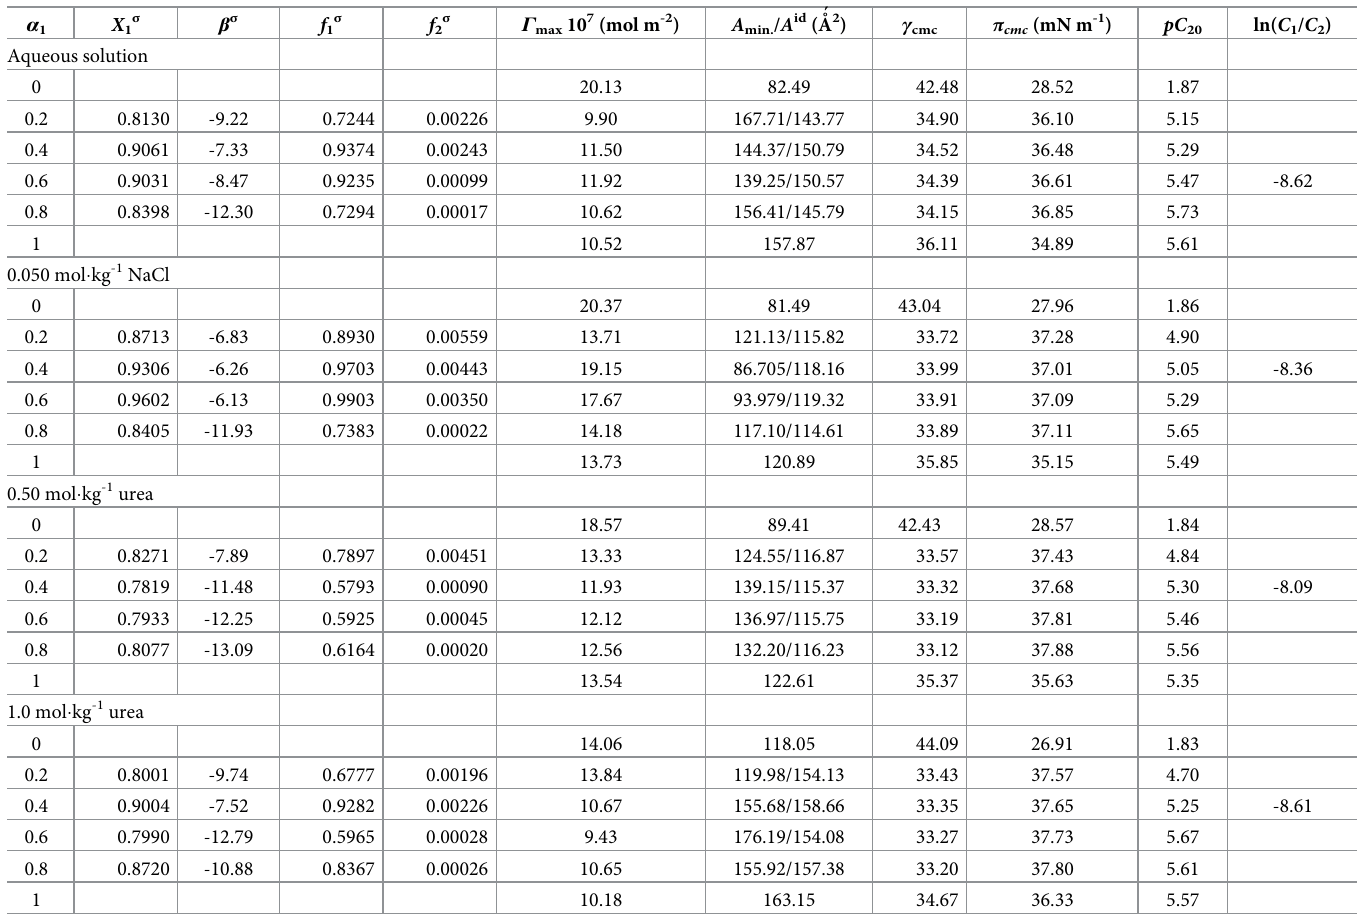
Table 2. Various interfacial parameters for AMT+14-E2-14 mixed system in diverse solvent at 298.15 K. α